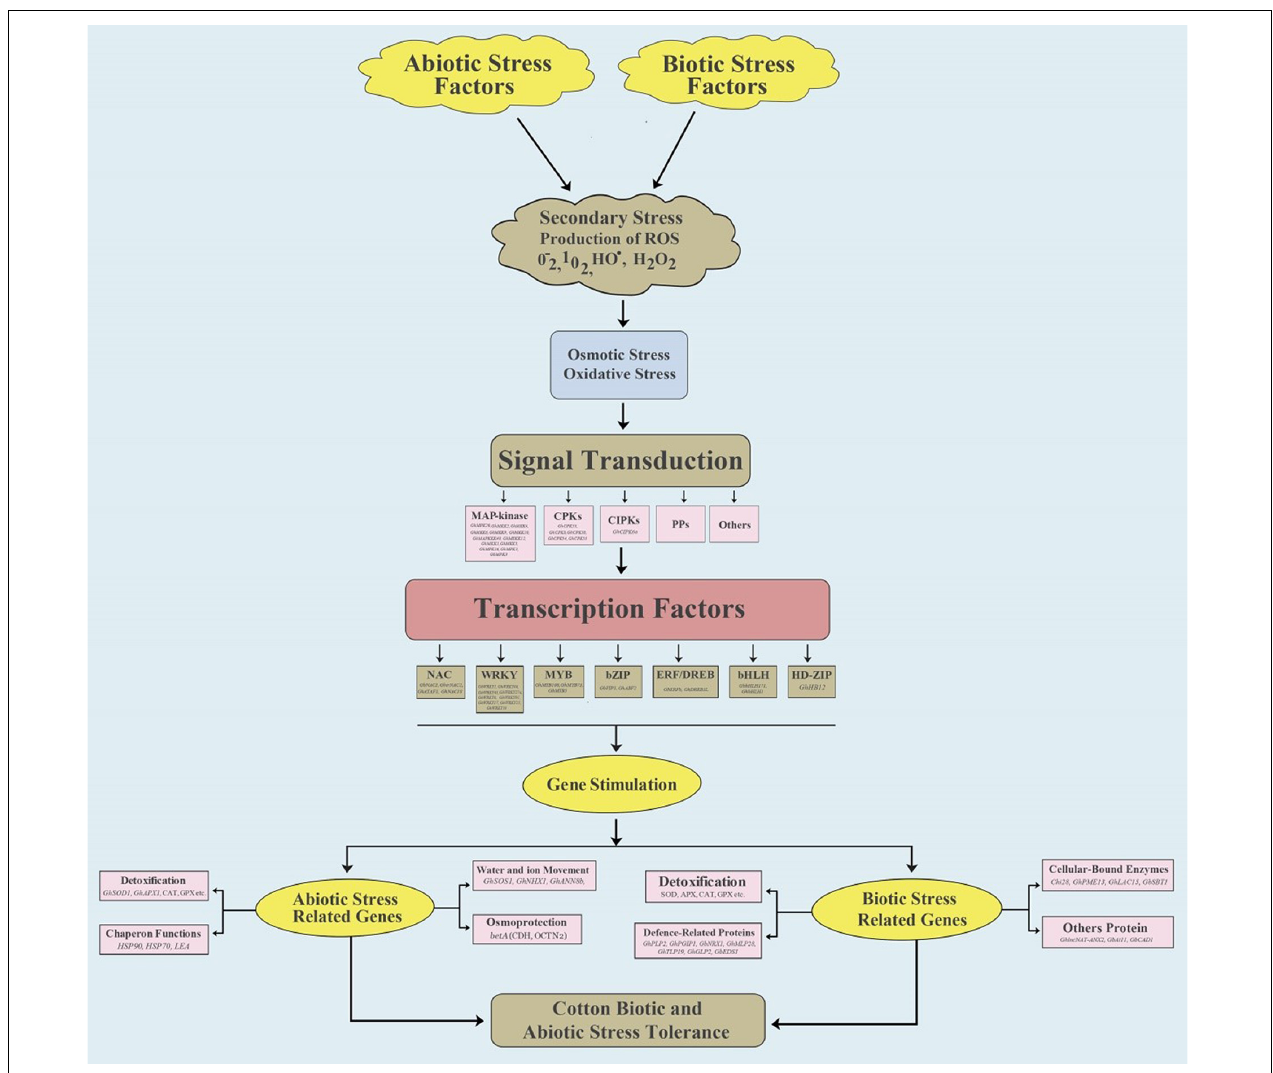
FIGURE 1 | Overall representation of cotton gene regulatory networks in response to abiotic (Salt and Drought) and biotic ( Verticillium and Fusarium ) stresses. In the MAP-kinase signaling, abiotic stress genes include GhMAPKKK49 , GhMEKK12 , GhMKK1 , GhMKK3 , GhMPK16 , GhMPK3 , and GbMPK3 , while biotic stress genes include GhMPK20 , GhMKK10 , GhMKK9 , GhMKK6 , GhMKK4 , and GhMKK2 . In the CPKs family, GhCPK8 , GhCPK38 , GhCPK54, and GhCPK55 are involved in abiotic stress, and GhCPK33 is involved in biotic stress. In the CIPKs family, GhCIPK6a is involved in abiotic stress. In the transcriptional factors, for abiotic and biotic stress, NAC includes GhirNAC2 , GhATAF1 , GhNAC18, and GbNAC1 , MYB includes GhMYB73 , GbMYB5 , GhMYB108 , and GhMYB108 , WRKY includes GhWRKY46 , GhWRKY41 , GhWRKY27a , GhWRKY6 , GhWRKY91 , GhWRKY17 , GhWRKY25 , GhWRKY33 , and GbWRKY1 , bZIB includes GhABF2 and GbVIP1 , ERF/DREB includes GhERF2 , GhDREB1L , and GbERFb , and bHLH includes GhbHLH1 and GbbHLH171 . HD-ZIP includes GhHB12 for biotic